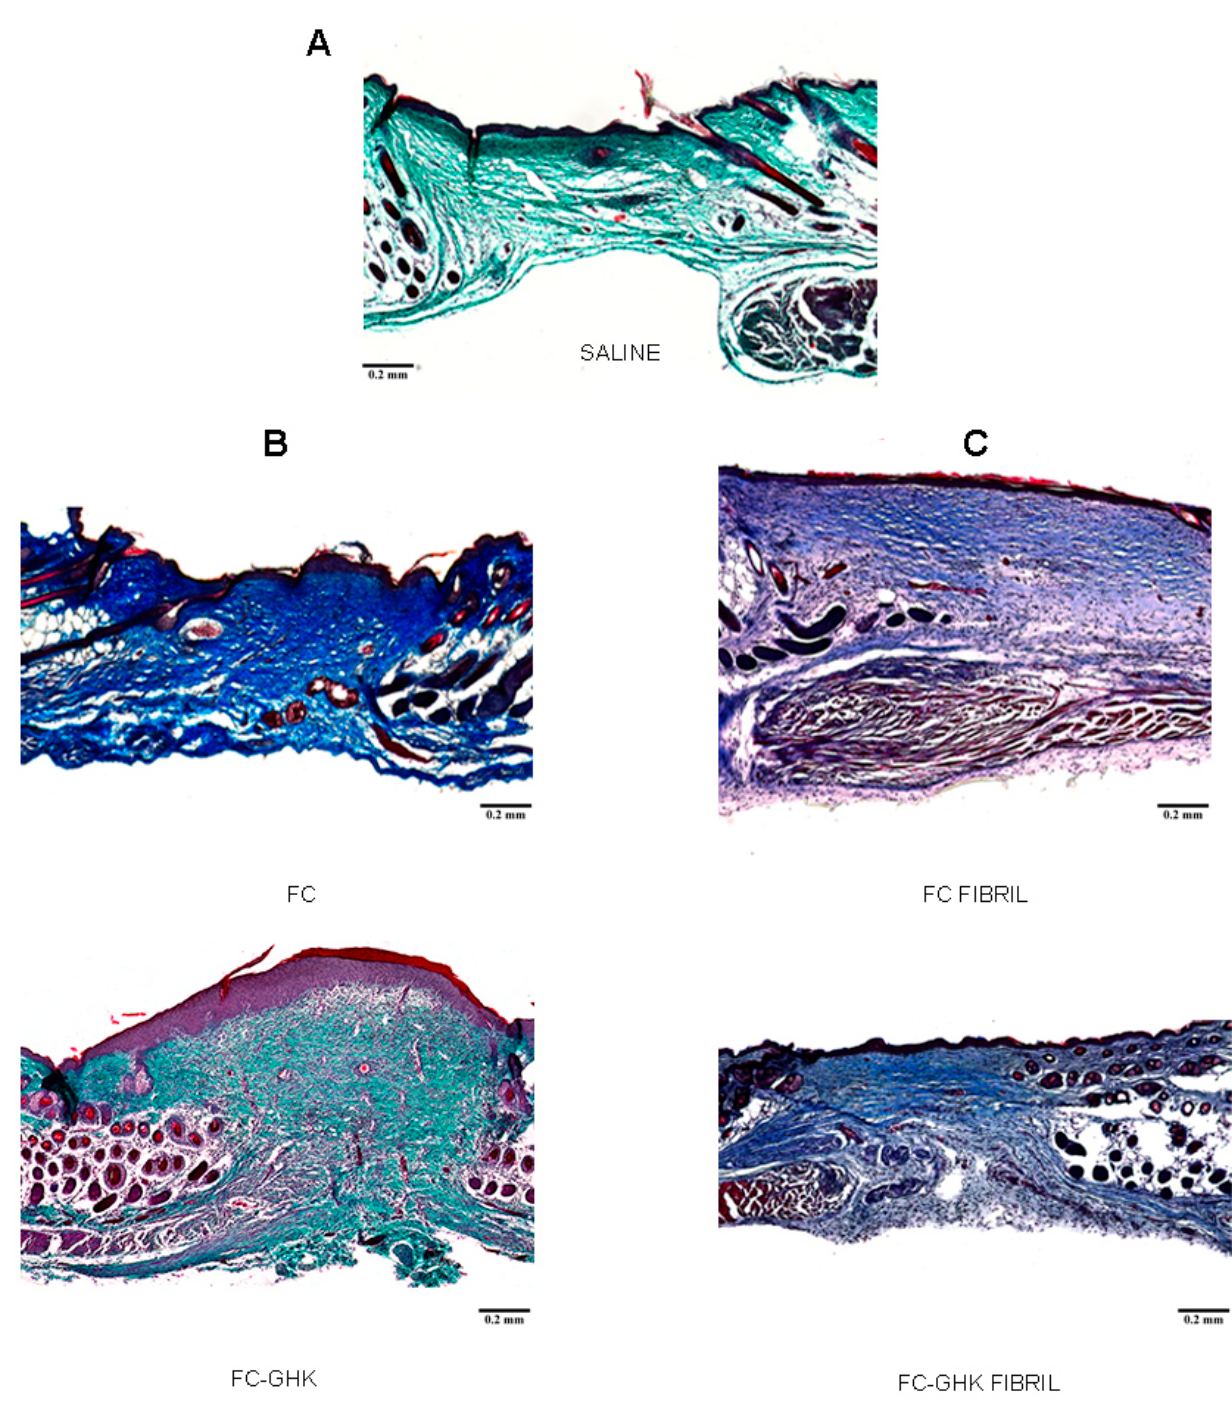
Figure 15. Representative images of histological samples on day 18 after injury: ( A ) saline; ( B )-left panel non-fibrillated peptides FC and FC-GHK; ( C )-right panel fibrillated peptides FC and FC-GHK. Skin samples stained with Masson’s trichrome. Scale bar 0.2 mm.